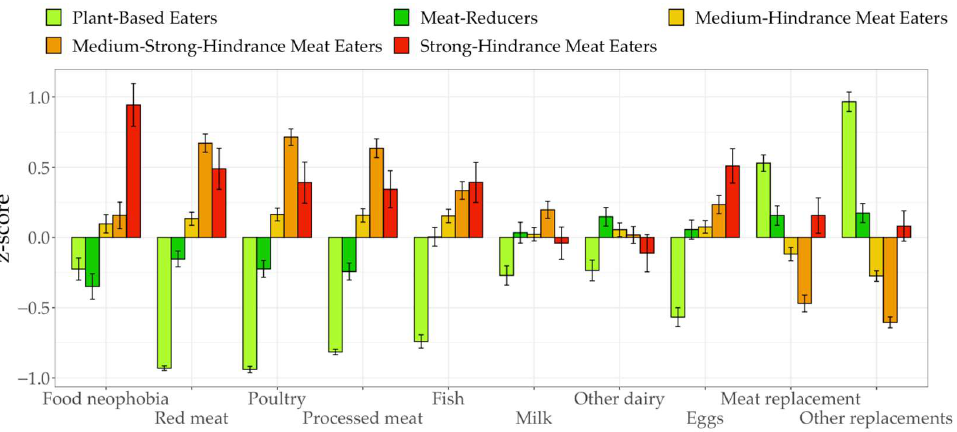
Figure 1. Means of outcome variables between profiles.